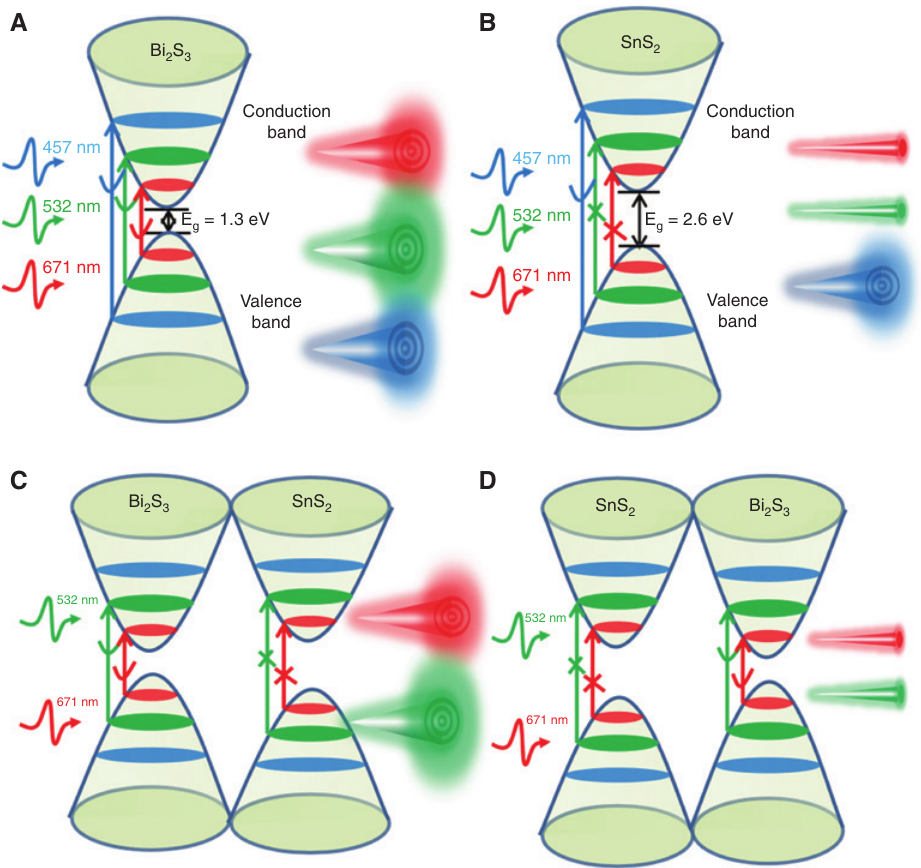
Figure 6: Microscopic principle of SSPM and all-optical diode. (A) The schematic diagram of SSPM based on Bi all-optical diode; and (D) negative propagation of light of all-optical